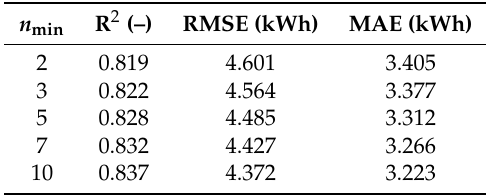
Table 7. Results of different n min , where K = n and M = 1000.